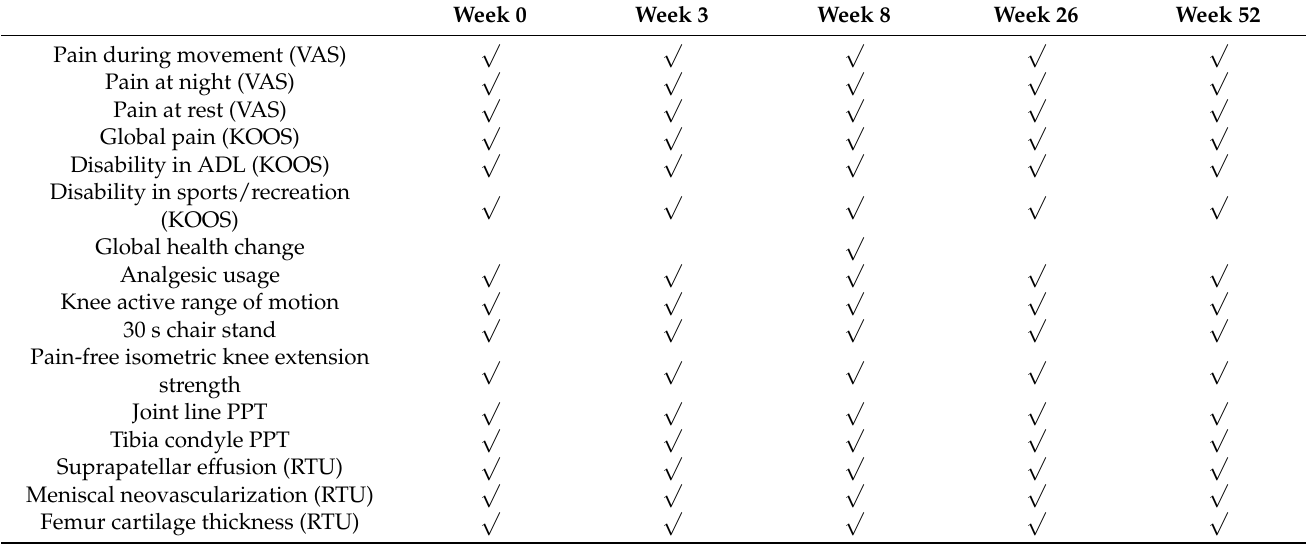
Table 1. Timetable of outcome